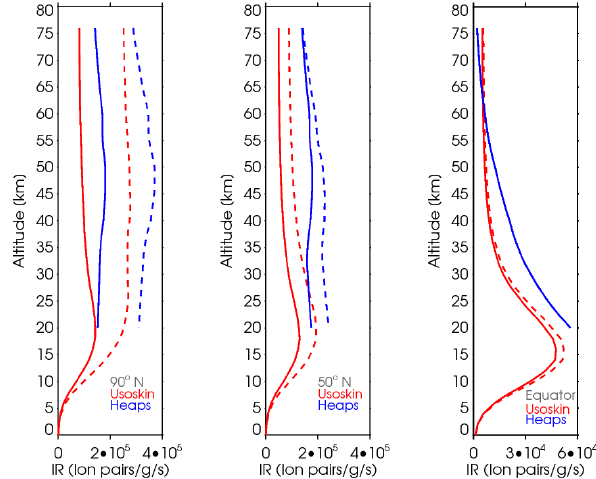
2 Fig. 1. Red lines: ionization rates (number of ion pairs pro- 3 duced per air mass and time unit) for several geomagnetic latitudes as computed by the CRAC:CRII model (Usoskin, Kovaltsov and Mironova, 2010). Blue lines: ionization rate computed by Heaps, (1978). Solid lines: ionization rate during solar maximum. Dashed lines: ionization rate during solar minimum. Note different scales on abscissas in dependence on geomagnetic